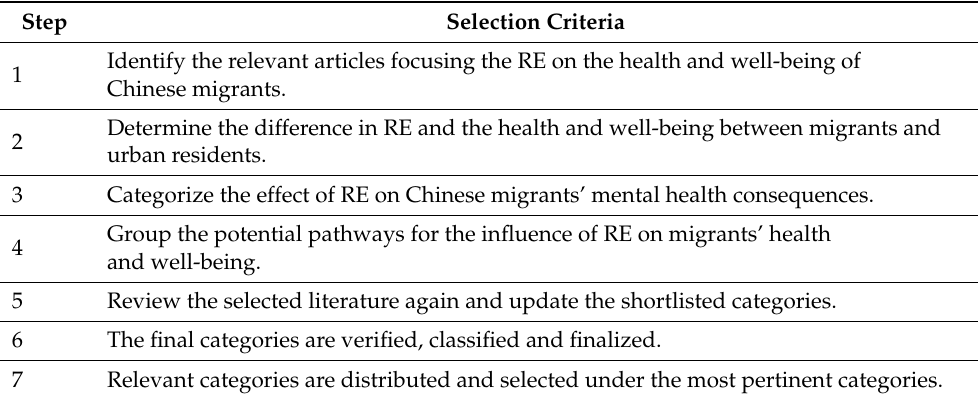
Table 3. Selection criteria for formulation